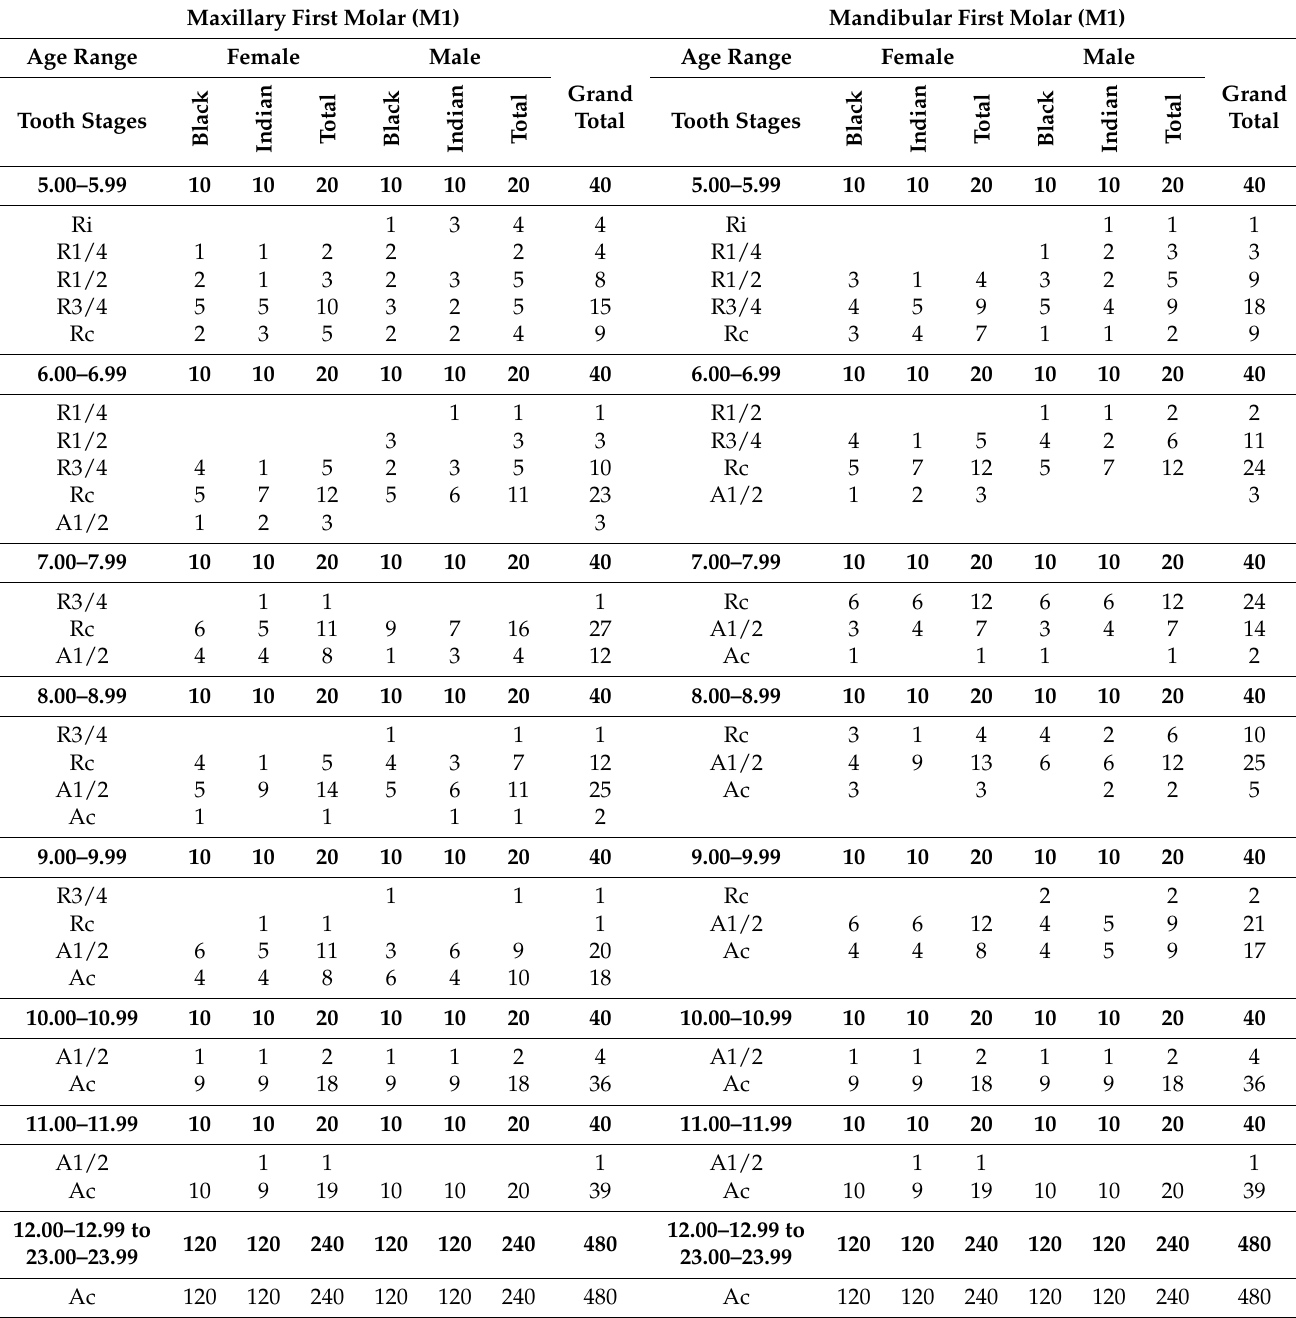
Table A6. Frequencies of the tooth development stages of the first molar for the SA Black and Indian population